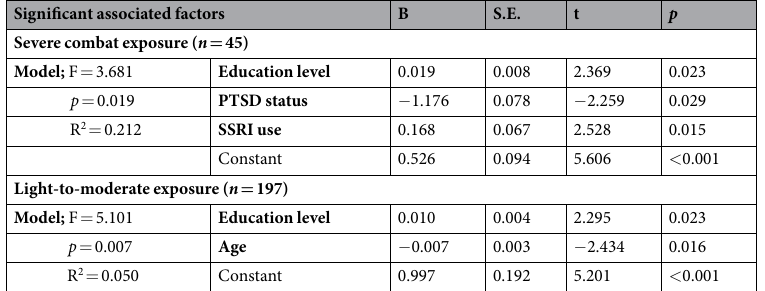
Table 2. Linear regression analysis to predict relative telomere length among combat veterans according to trauma exposure levels.